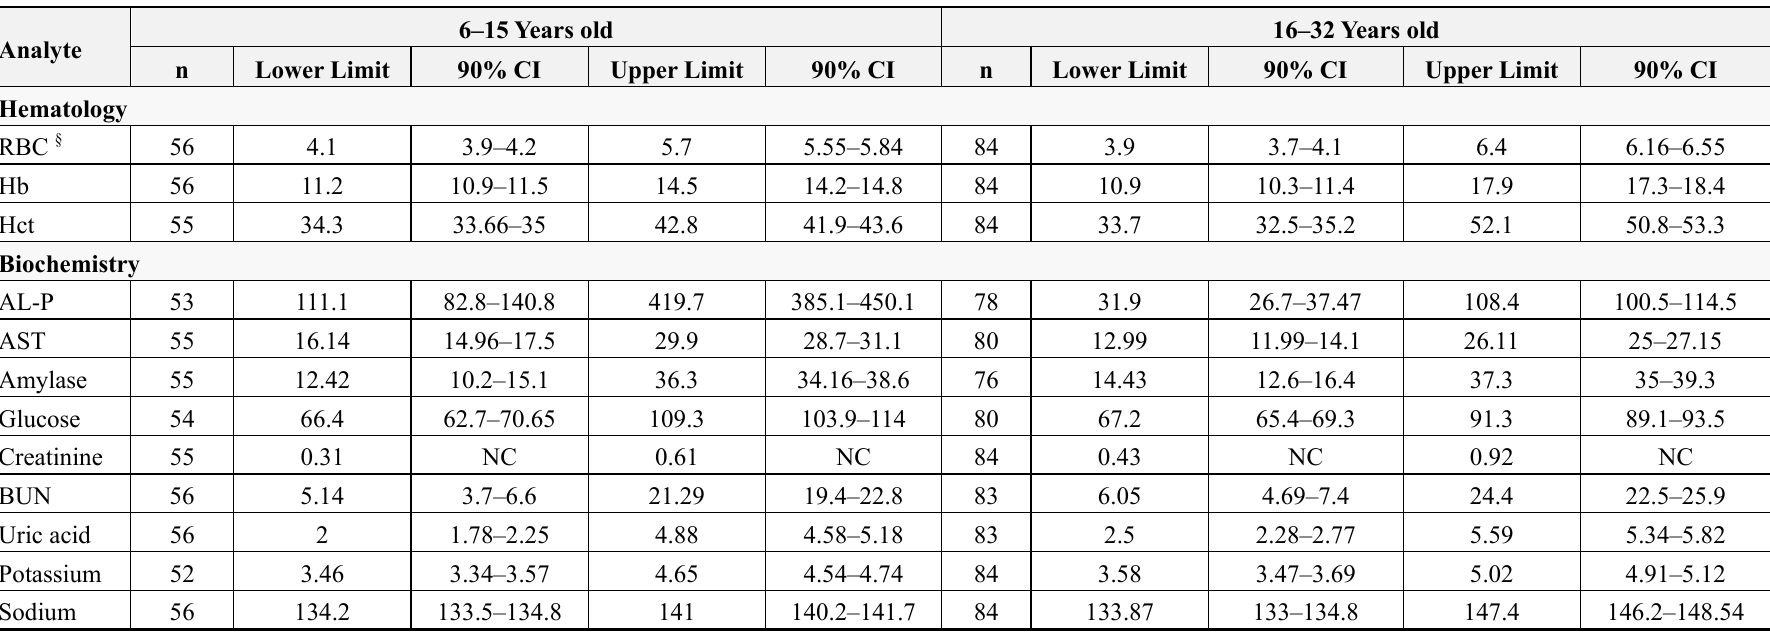
Table 3. 95% Reference interval for hematology and biochemistry analytes by age group